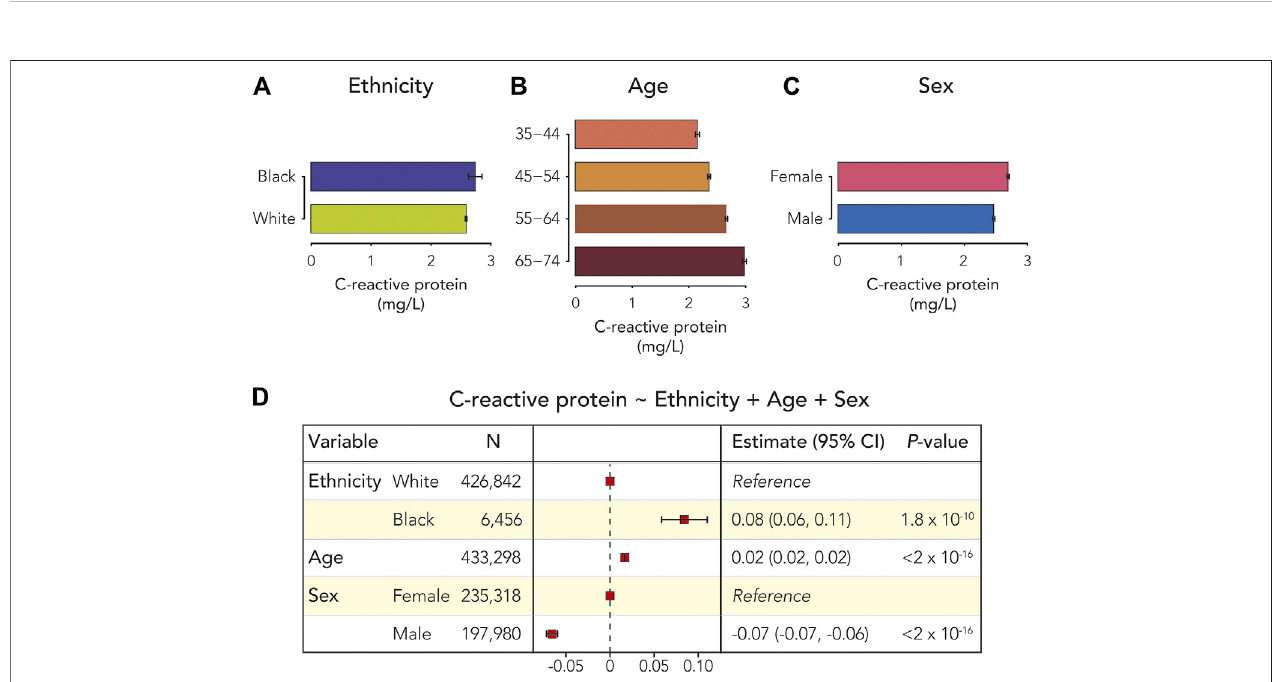
FIGURE1 | C-reactive protein (CRP), ethnicity, age,and sex. Average CRP serum levels ( ± 95%CI) are shown for (A) Black and White participants (B) age ranges, and (C) female and male participants. (D) Forest plot showing the results of the multivariable linear regression model of participant CRP serum levels. Effect sizes, 95% CIs, and p -values are shown for ethnicity, age, and